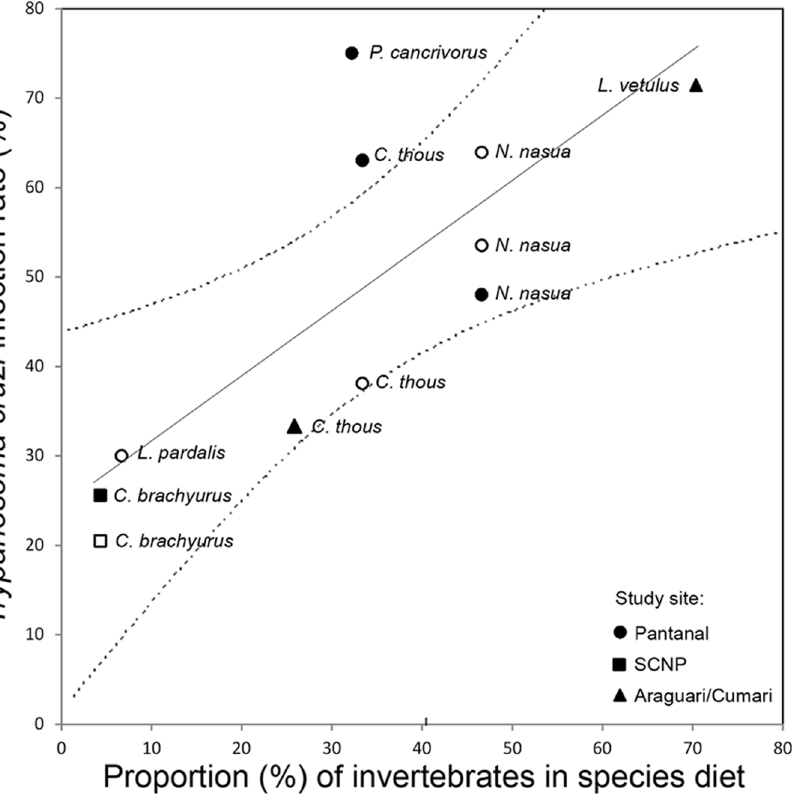
Figure 3. Trypanosomacruzi infection in Neotropical wild carnivores and the proportion of invertebrates in species’ diet. Infection rate (total examined/total positive*100) was determined by IFAT - Indirect Immunofluorescent Antibody Test. Studies sites were Pantanal – Mato Grosso do Sul State, Araguari - Minas Gerais State/Cumari – Goia´s State and Serra da Canastra National Park (SCNP) – Minas Gerais State, Brazil. The data set included samples collected on this study (filled symbols) and from the same studies sites previously published by our group. Species’ diets were retrieved from the literature (Table S1). The fitted linear regression (F(1,9): 14.9; r 2 =0.62, p=0.004) is represented by the solid line (y=0.73x + 24). Dashed lines indicate the confidence intervals at